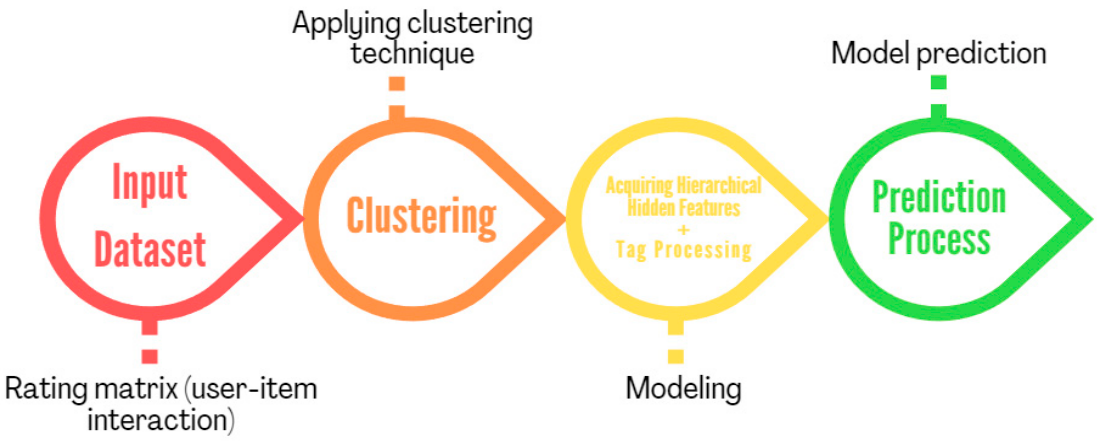
Figure 2. Modeling